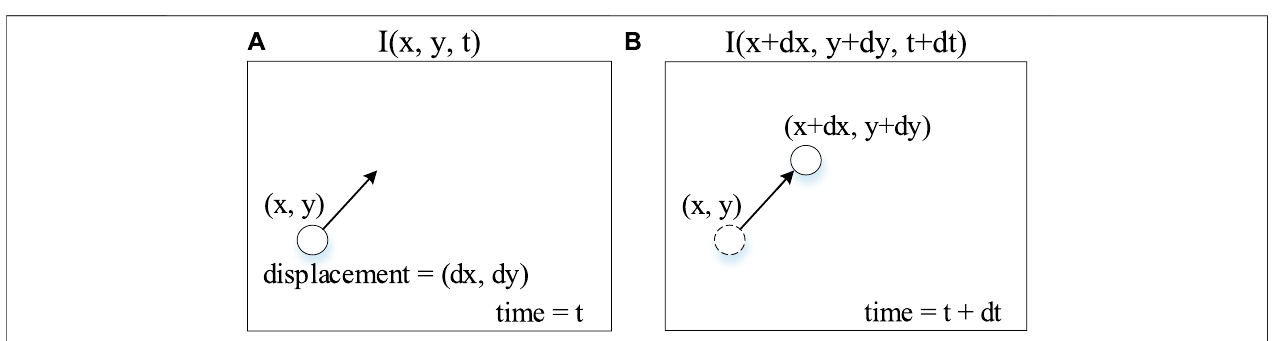
FIGURE 2 | (A) I represents the intensity of a pixel, and its related parameters are spatial position ( x , y ) and time t , that is I ( x , y , t ) . (B) In the next frame, the pixel moves the distance of ( dx , dy ) , and the interval time is dt